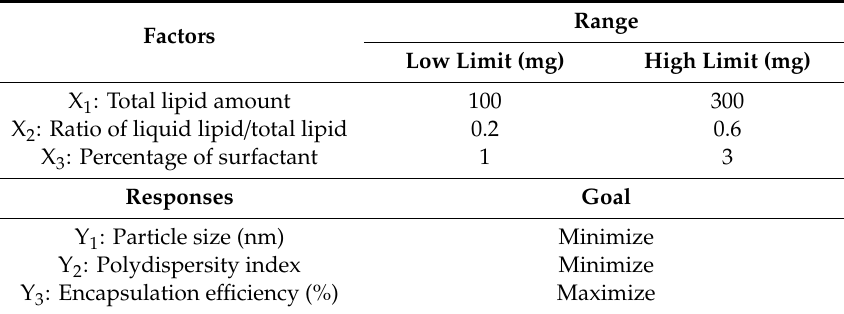
Table 1. Factors and responses used in Box–Behnken